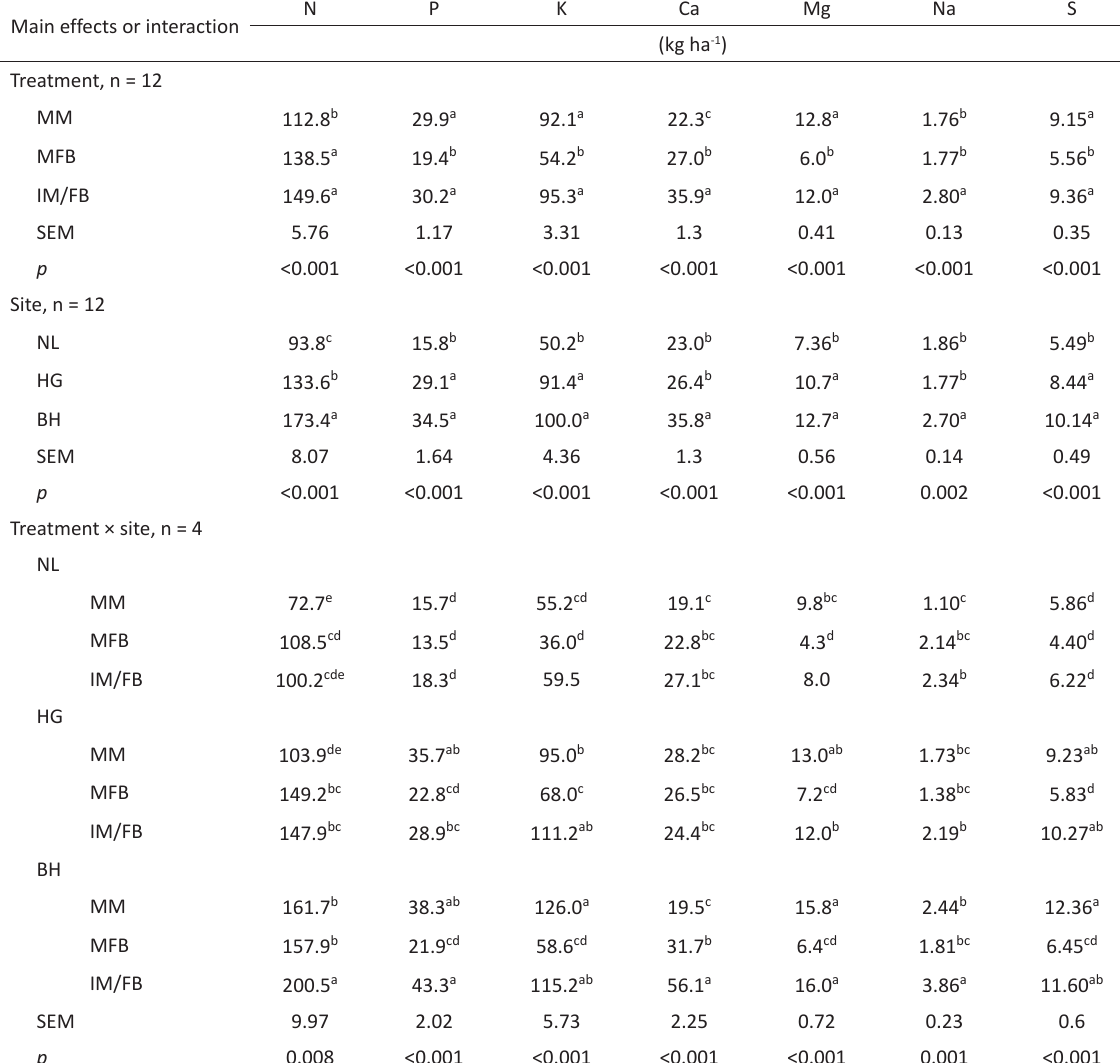
Table 7. Yield of macro nutrients in monocropped and intercropped maize and faba bean in three field experiments Main effects or